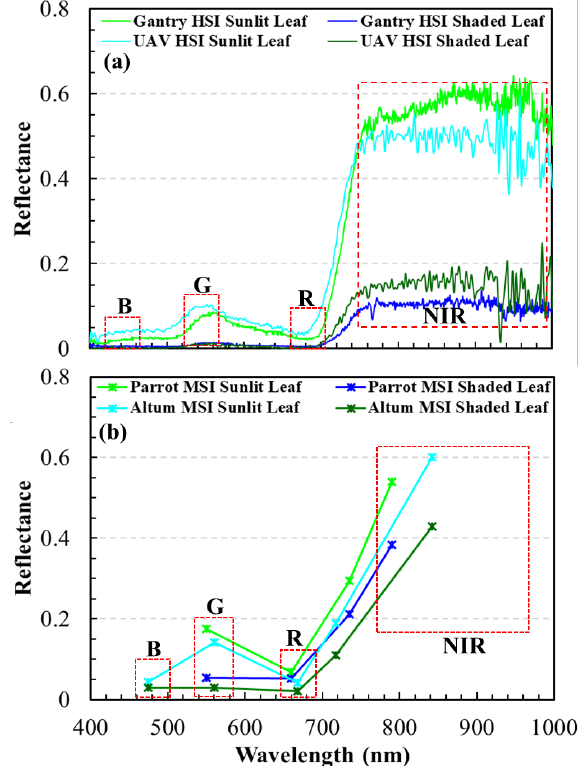
Figure 5. Spectral profiles of sunlit and shaded green vegetation extracted from hyperspectral (a) and multispectral (b) imagery.